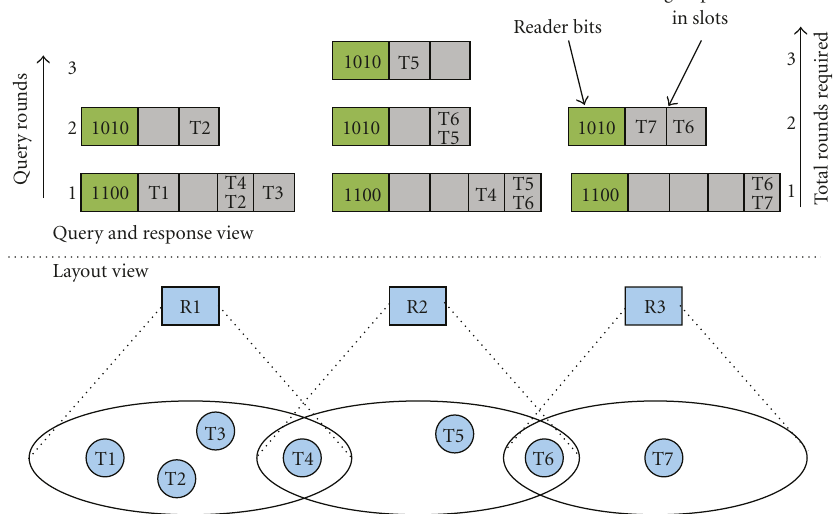
Figure 6: Working example of BLSync Protocol. The lower part of figure shows the layout of readers and tags within the read range of each. The upper part shows in detail the progression of BLSync over multiple rounds. In each round, all readers send a common query of bits and await responses over a frame of time slots. In each round, the query bits of all readers are the same. All tags are read after a total of 3 rounds of querying requiring 8-tag response time slots (4,2,2 in those rounds) in all.